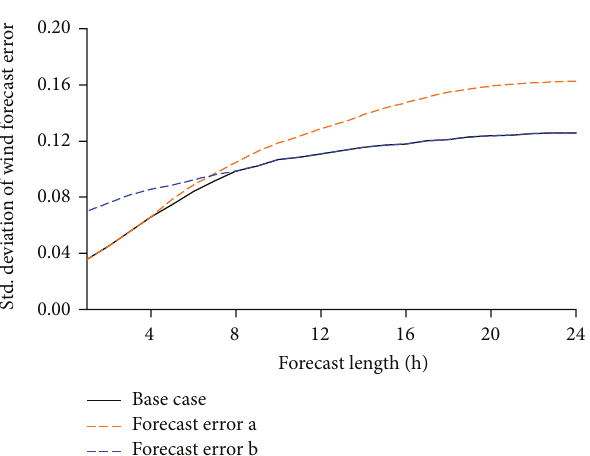
Figure 5: Different wind power forecast error curves for case